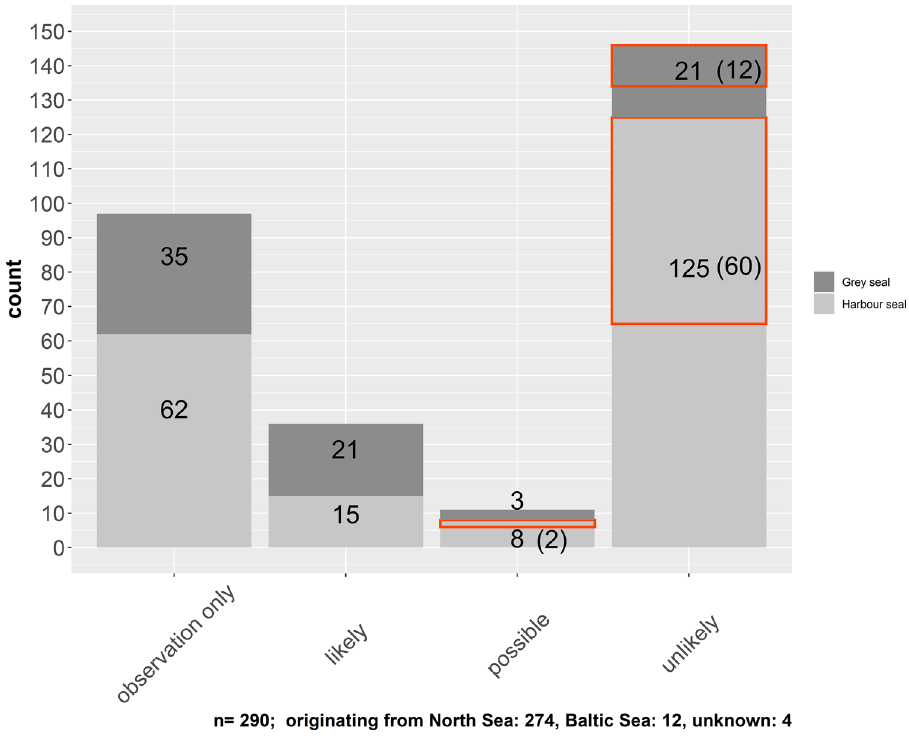
Figure 1. Number of suspected grey seal predation and fox related cases for the years 1995–2018; categorised by likelihood of grey seal predation (“likely”, “possible”, “unlikely”), cases that have only been observed but without recovery of the carcass (“observation only”) and suspected fox interactions. Cases related to fox interaction were included in the category “unlikely” and possible in terms of grey seal predation and are highlighted by a red square. The number is shown in brackets. The definite case from 2018 is included as likely in this figure. Number of grey seal victims are shown in dark grey, number of harbour seal victims in light grey